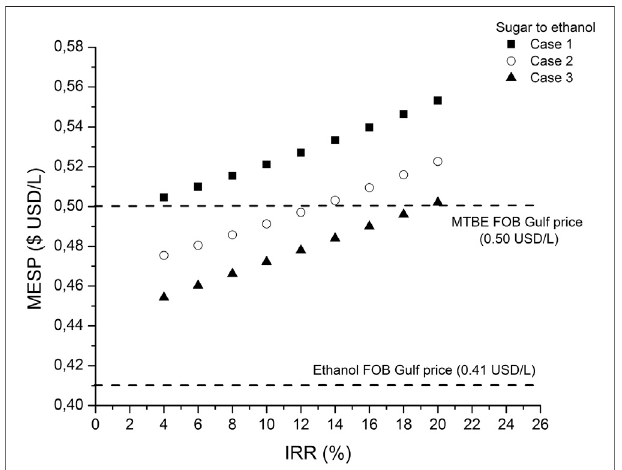
FIGURE 6 | Fitting of MESP (USD/L) vs. IRR (%) for scenario 2 and all three cases in sugar to ethanol.